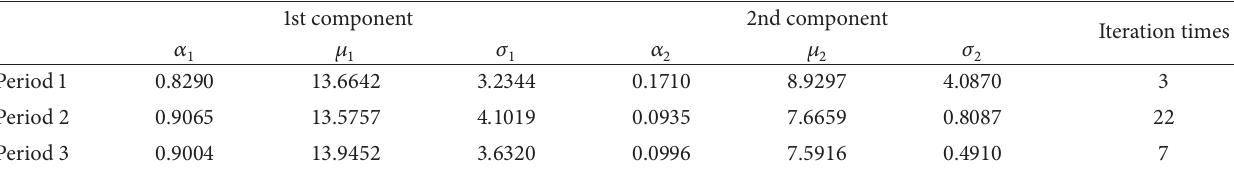
Table 2: Estimated parameter values of Gaussian mixture distribution based on EM algorithm. 1st